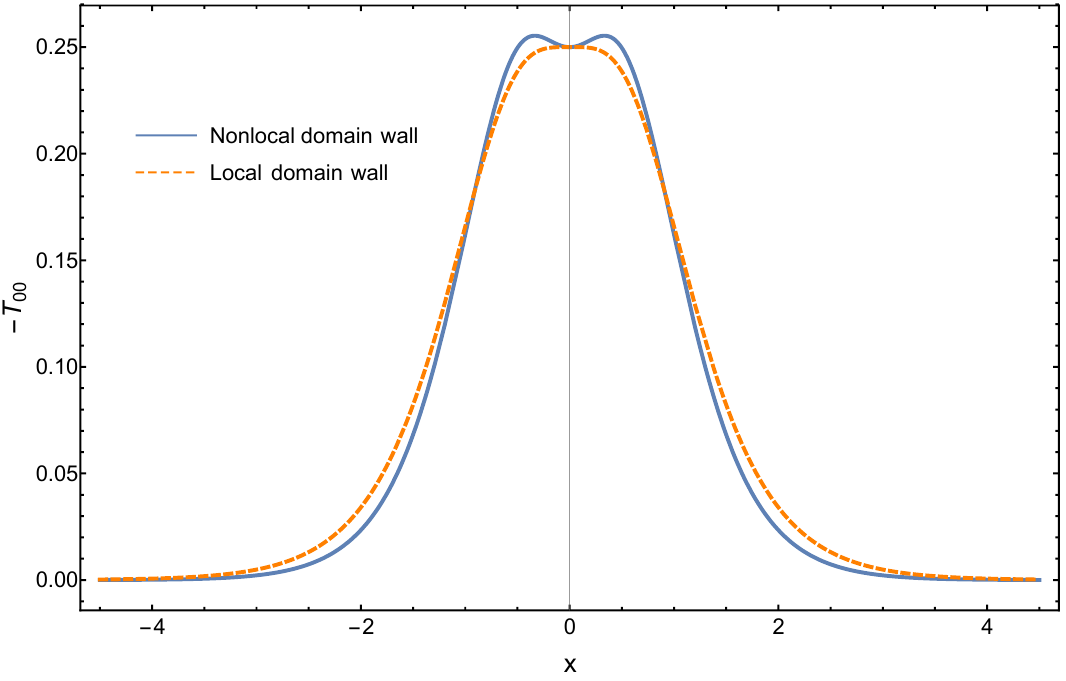
Figure 3 . In this figure we show the energy density E ( x ) = − T 00 of the linearized nonlocal domain wall solution φ ( x ) = φ ( x ) + δφ ( x ) (solid blue line) in comparison with the one of the local domain L wall (orange dashed line). We set λ = 2 , v = 1 and M 2 = 14 . 3 s